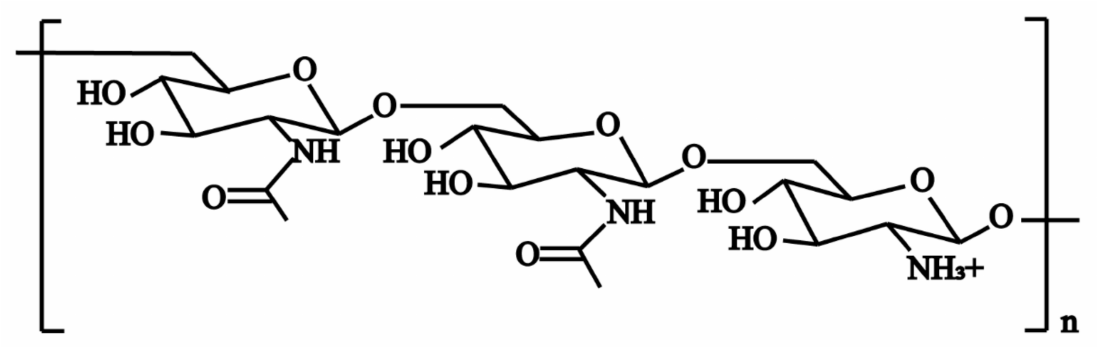
Figure 2. The structure of polysaccharide intercellular adhesin (PIA). PIA is a beta-linear homogly- can composed of 1,6-linked N-acetylglucosamine residues, 15–20% of which are deacetylated and therefore positively charged [41].